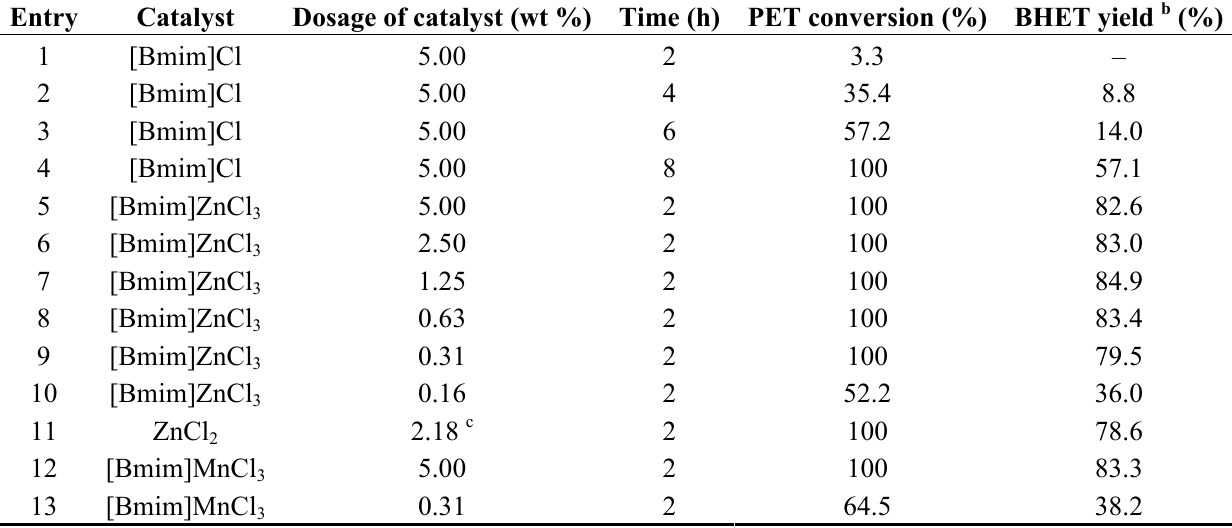
Table 1. Effect of catalysts on the glycolysis reaction of PET a